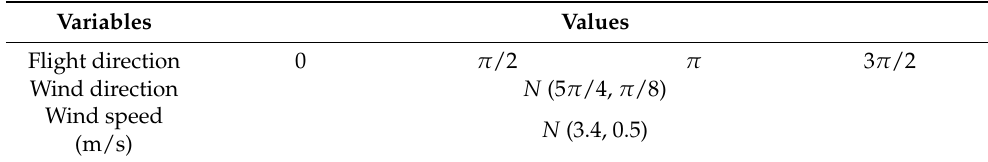
Table 7. Parameters for different flight